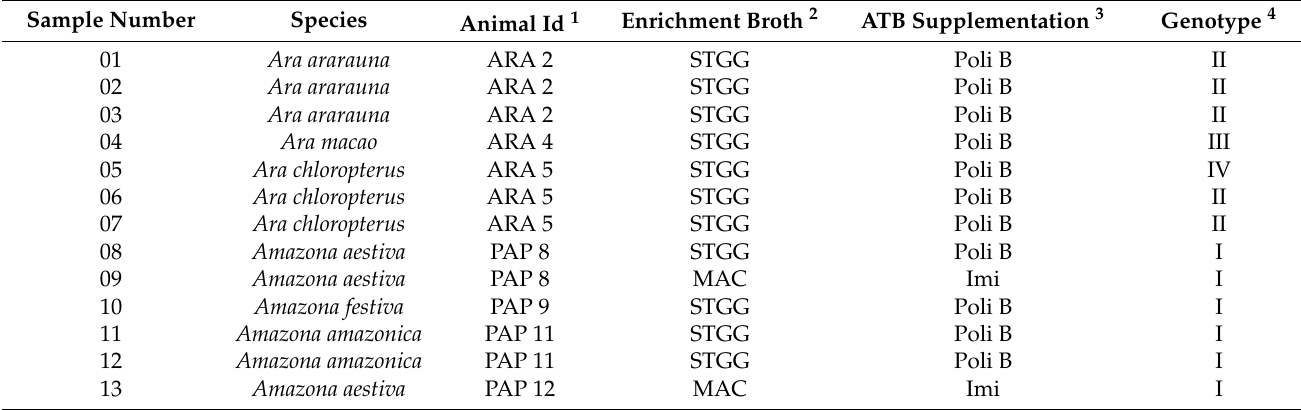
Table 5. bla KPC-positive E. coli isolated from trafficked Psittaciformes kept at the Centro de Triagem de Animais Silvestres da Para í ba (CETAS-PB), located in the Restinga de Cabedelo National Forest, Brazil. Sample Number